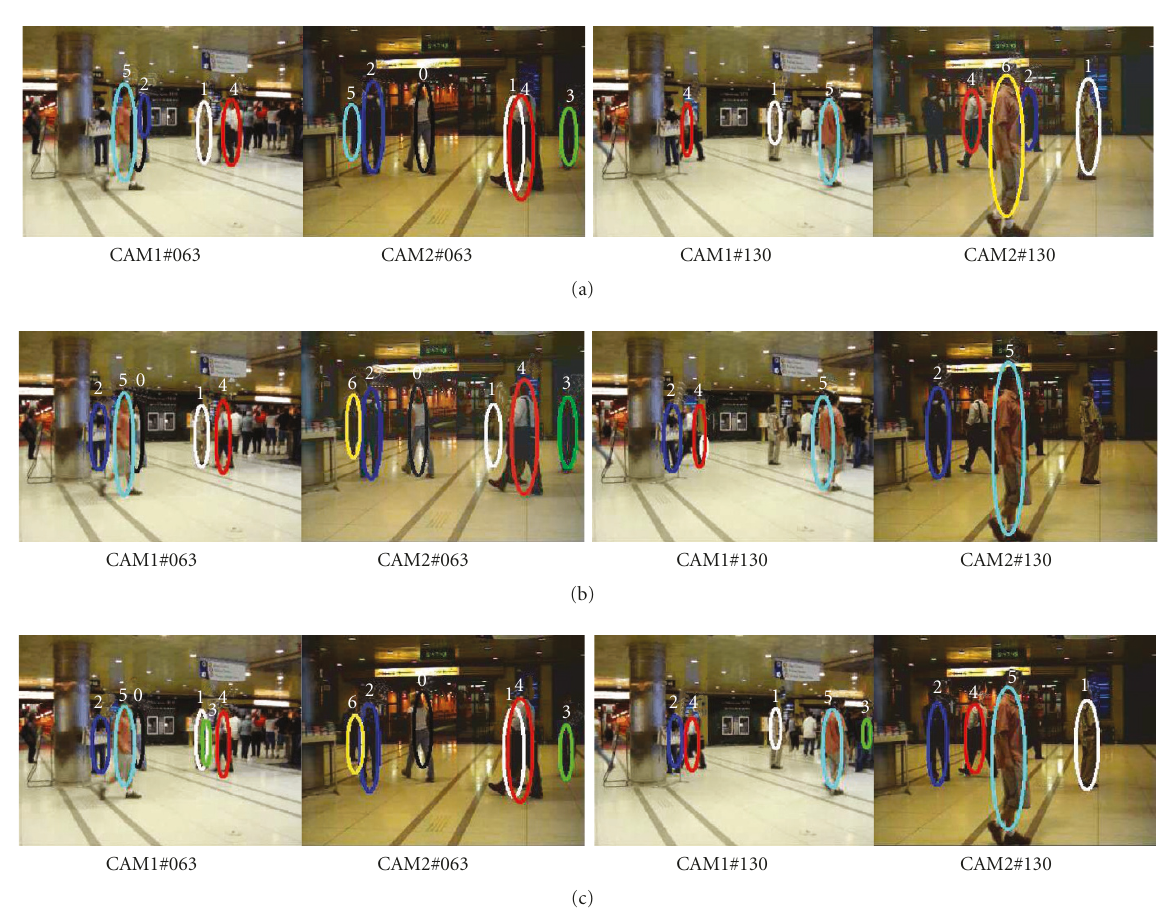
Figure 9: Tracking results of the videos UnionStation : (a) interactively distributed multiple-object tracking (IDMOT) [14]; (b) color-based multicamera tracking approach (CMCT) [30]; (c) the proposed